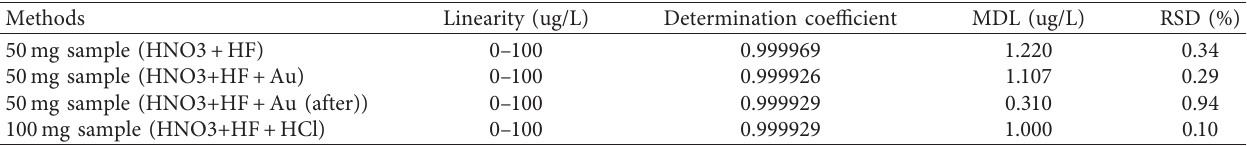
Table 4: Calibration curves and method detection limit (MDL) of